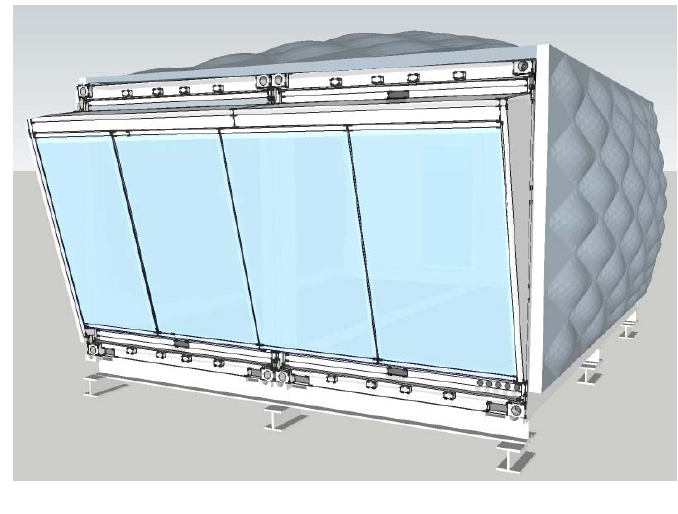
Figure 12. Drawing of BubbleZERO with new façade